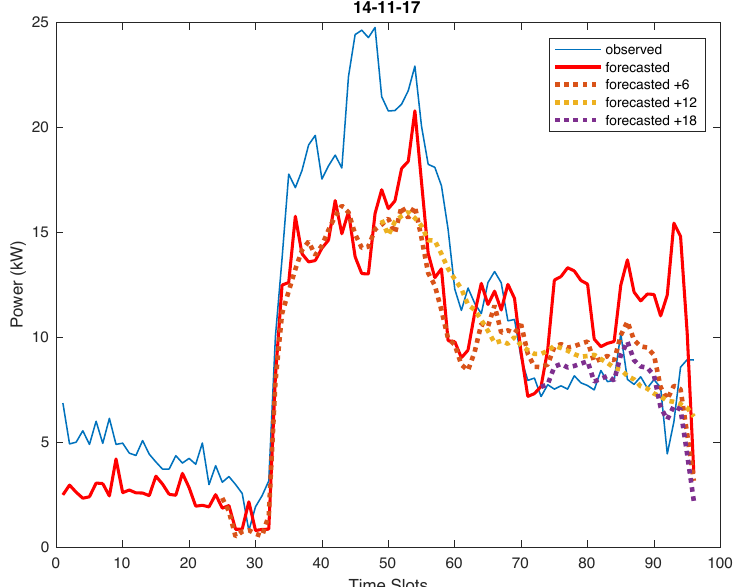
Figure 14. Pilot system: School (Palo del Colle), Day: 14 November 17. Daily forecasts vs. observed power consumption.